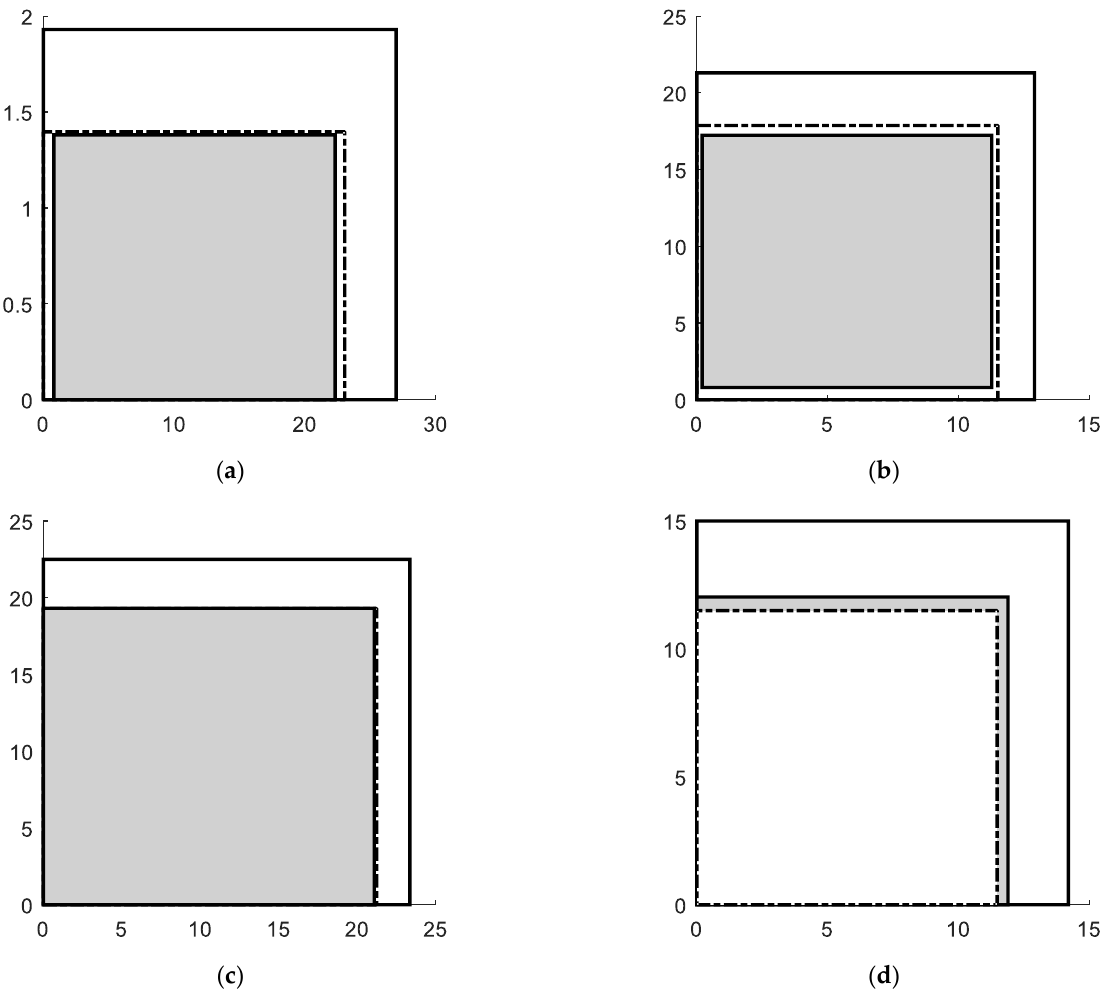
Figure 8. Footprint areas of the initial design (white rectangle, solid line), as well as the designs optimized using the proposed (white rectangle, dash-dotted line), and the basic TR routine (grey rectangle, solid line): ( a ) Circuit I, ( b ) Circuit II, ( c ) Circuit III, and ( d ) Circuit IV.